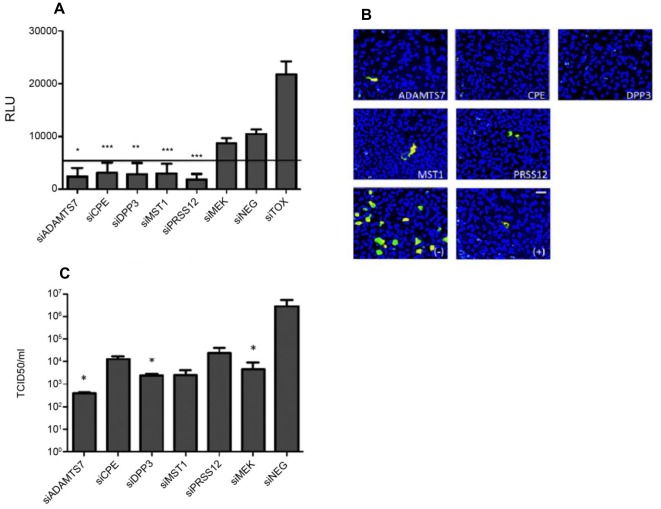
RNAi of 5 host protease genes down-regulated influenza virus replication.A: A549 cells were reverse transfected with 50 nM of siRNA (SMARTpool) specific for the indicated genes (ADAMTS7, CPE, DPP3, MST1, PRSS12). After 48 hours, cytotoxicity was determined by adenylate kinase (AK) release. Cells treated with the siTOX control were considered 100% cytotoxic and all values were normalized to siTOX. RLU = relative luciferase units. * p<0.05 vs siNEG, ** p<0.01 vs siNEG, ***p<0.005 vs siNEG; siTOX vs all samples: p<0.001 (not shown). Line shows 20% of siTOX control. B: A549 cells were reverse transfected with 50 nM of siRNA (SMARTpool) specific for the indicated genes (ADAMTS7, CPE, DPP3, MST1, PRSS12). After 48 hours, cells were infected with A/WSN/33 at an MOI of 0.001. 48 hours post-infection, cells were fixed in 4% formaldehyde and stained with an anti-NP (green) monoclonal antibody followed by counterstain with DAPI (blue.) Positive (+) control: siMEK, negative (−) control: siNEG. Magnification is 20× (bar is 100 microns). C: Cells were transfected with 100 nM of a novel siRNA targeting a different seed site from the SMARTpool used in the primary screen and infected as in B. After 48 hours of infection, cellular supernatant was tested for infectious virus production by a modified TCID50. Data is expressed as TCID50/ml. Data is representative of two independent experiments. (*p<0.05 vs siNEG).